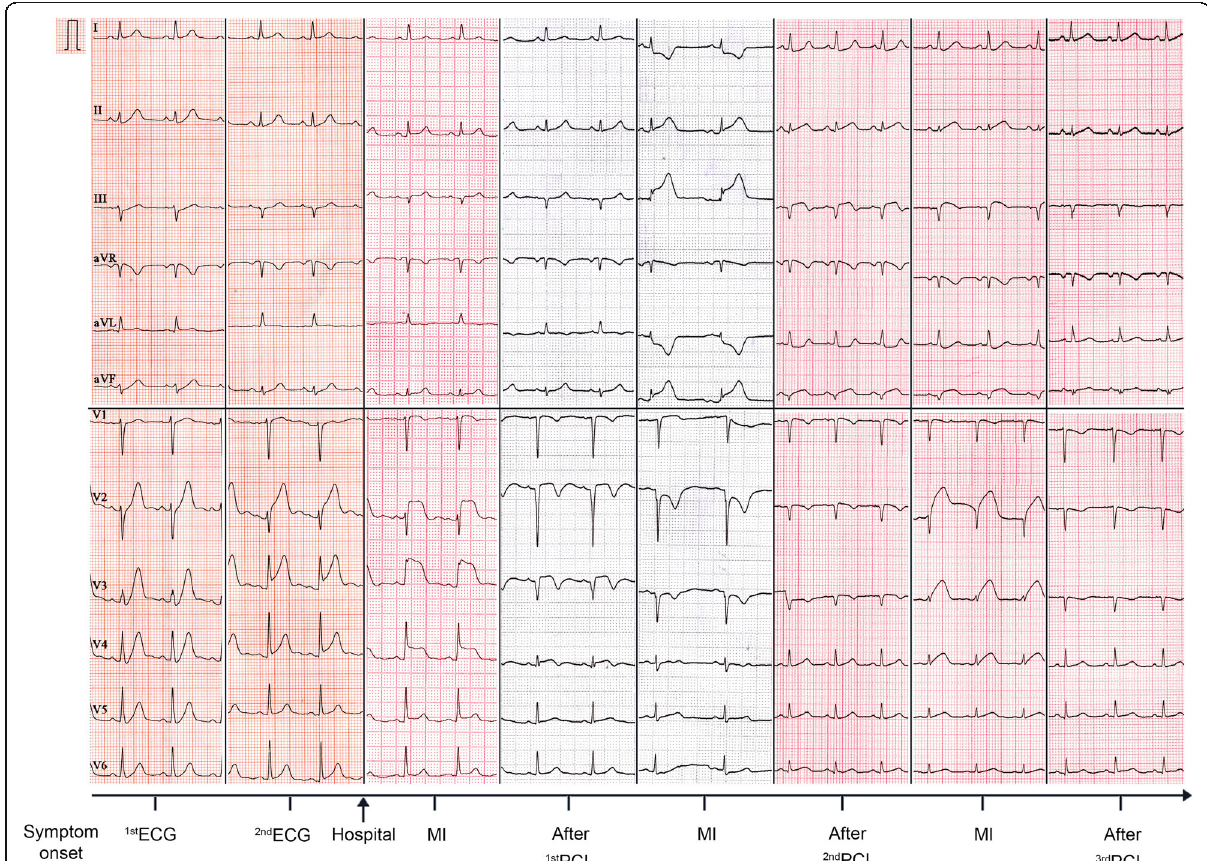
Fig. 1 The dynamic changes in the electrocardiogram (ECG) of a patient from symptom onset to discharge of the hospital. PCI: percutaneous coronary intervention, myocardial infarction